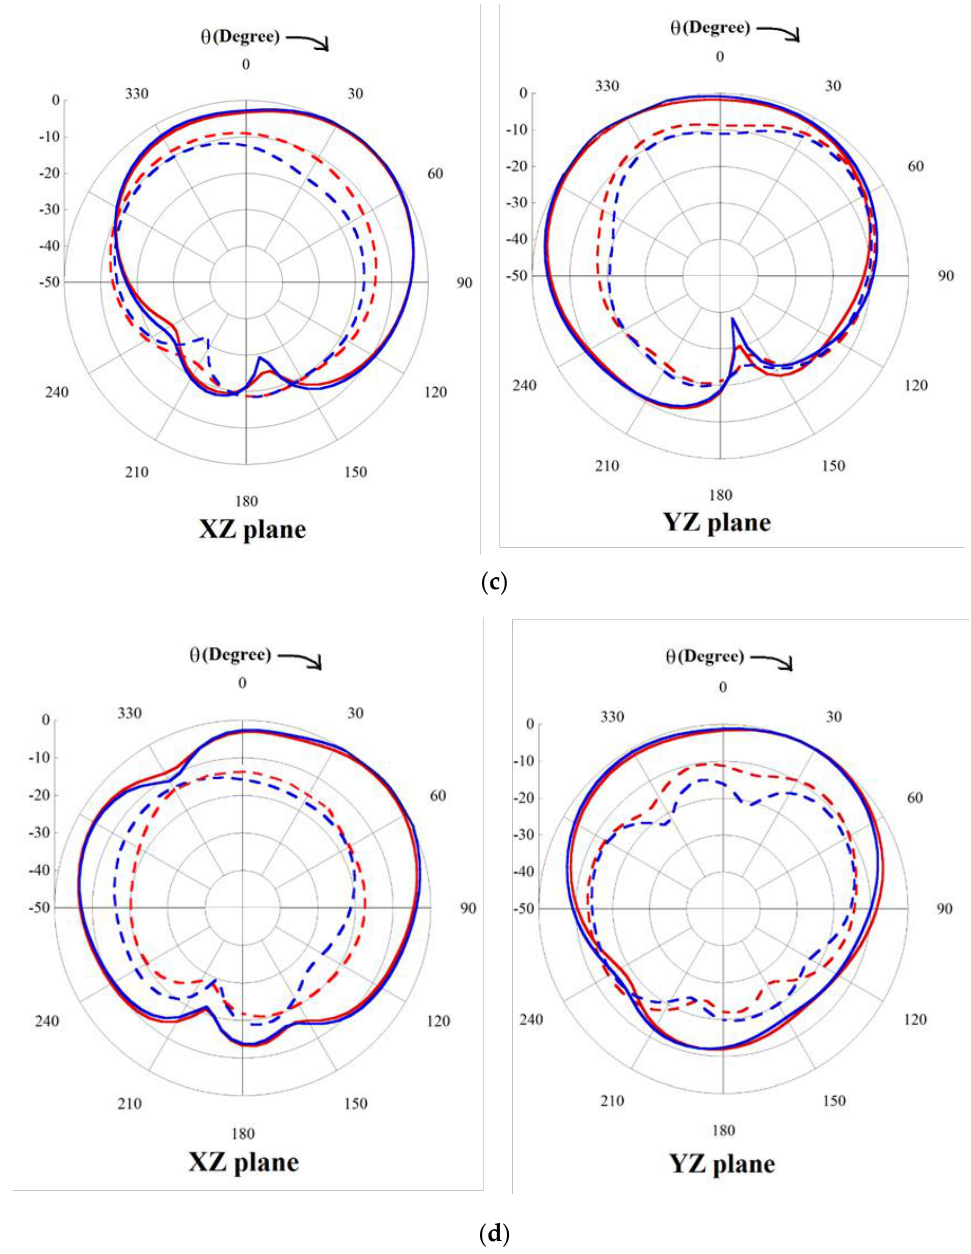
Figure 12. Normalized copolar and crosspolar radiation pattern of the four element MIMO at ( a ) 1st resonance, ( b ) 2nd resonance, ( c ) 3rd resonance and ( d ) 4th resonance. Table 5. Comparison table of measured and simulated antenna parameters of the four element MIMO antenna.